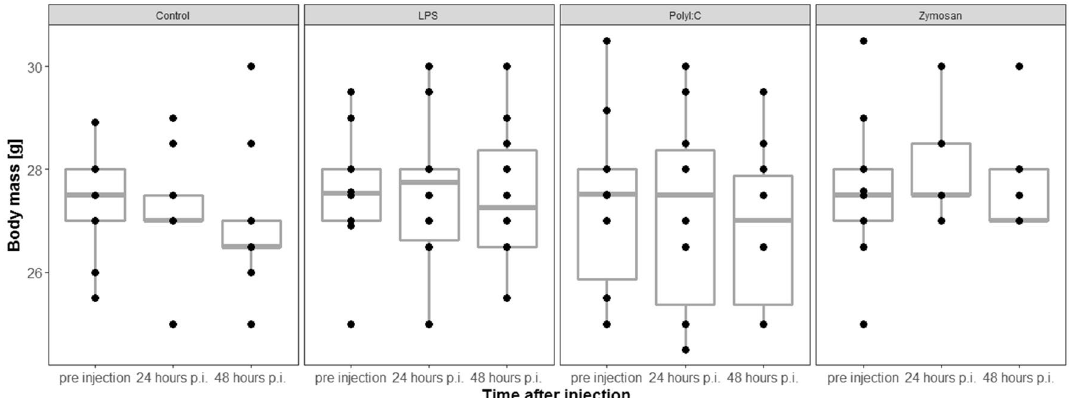
Figure 2. Body mass change was not affected by antigen type. p.i. = post injection. The figures show medians (bold line), 25–75% percentiles (box), maxima and minima (whiskers) and data points (dots).